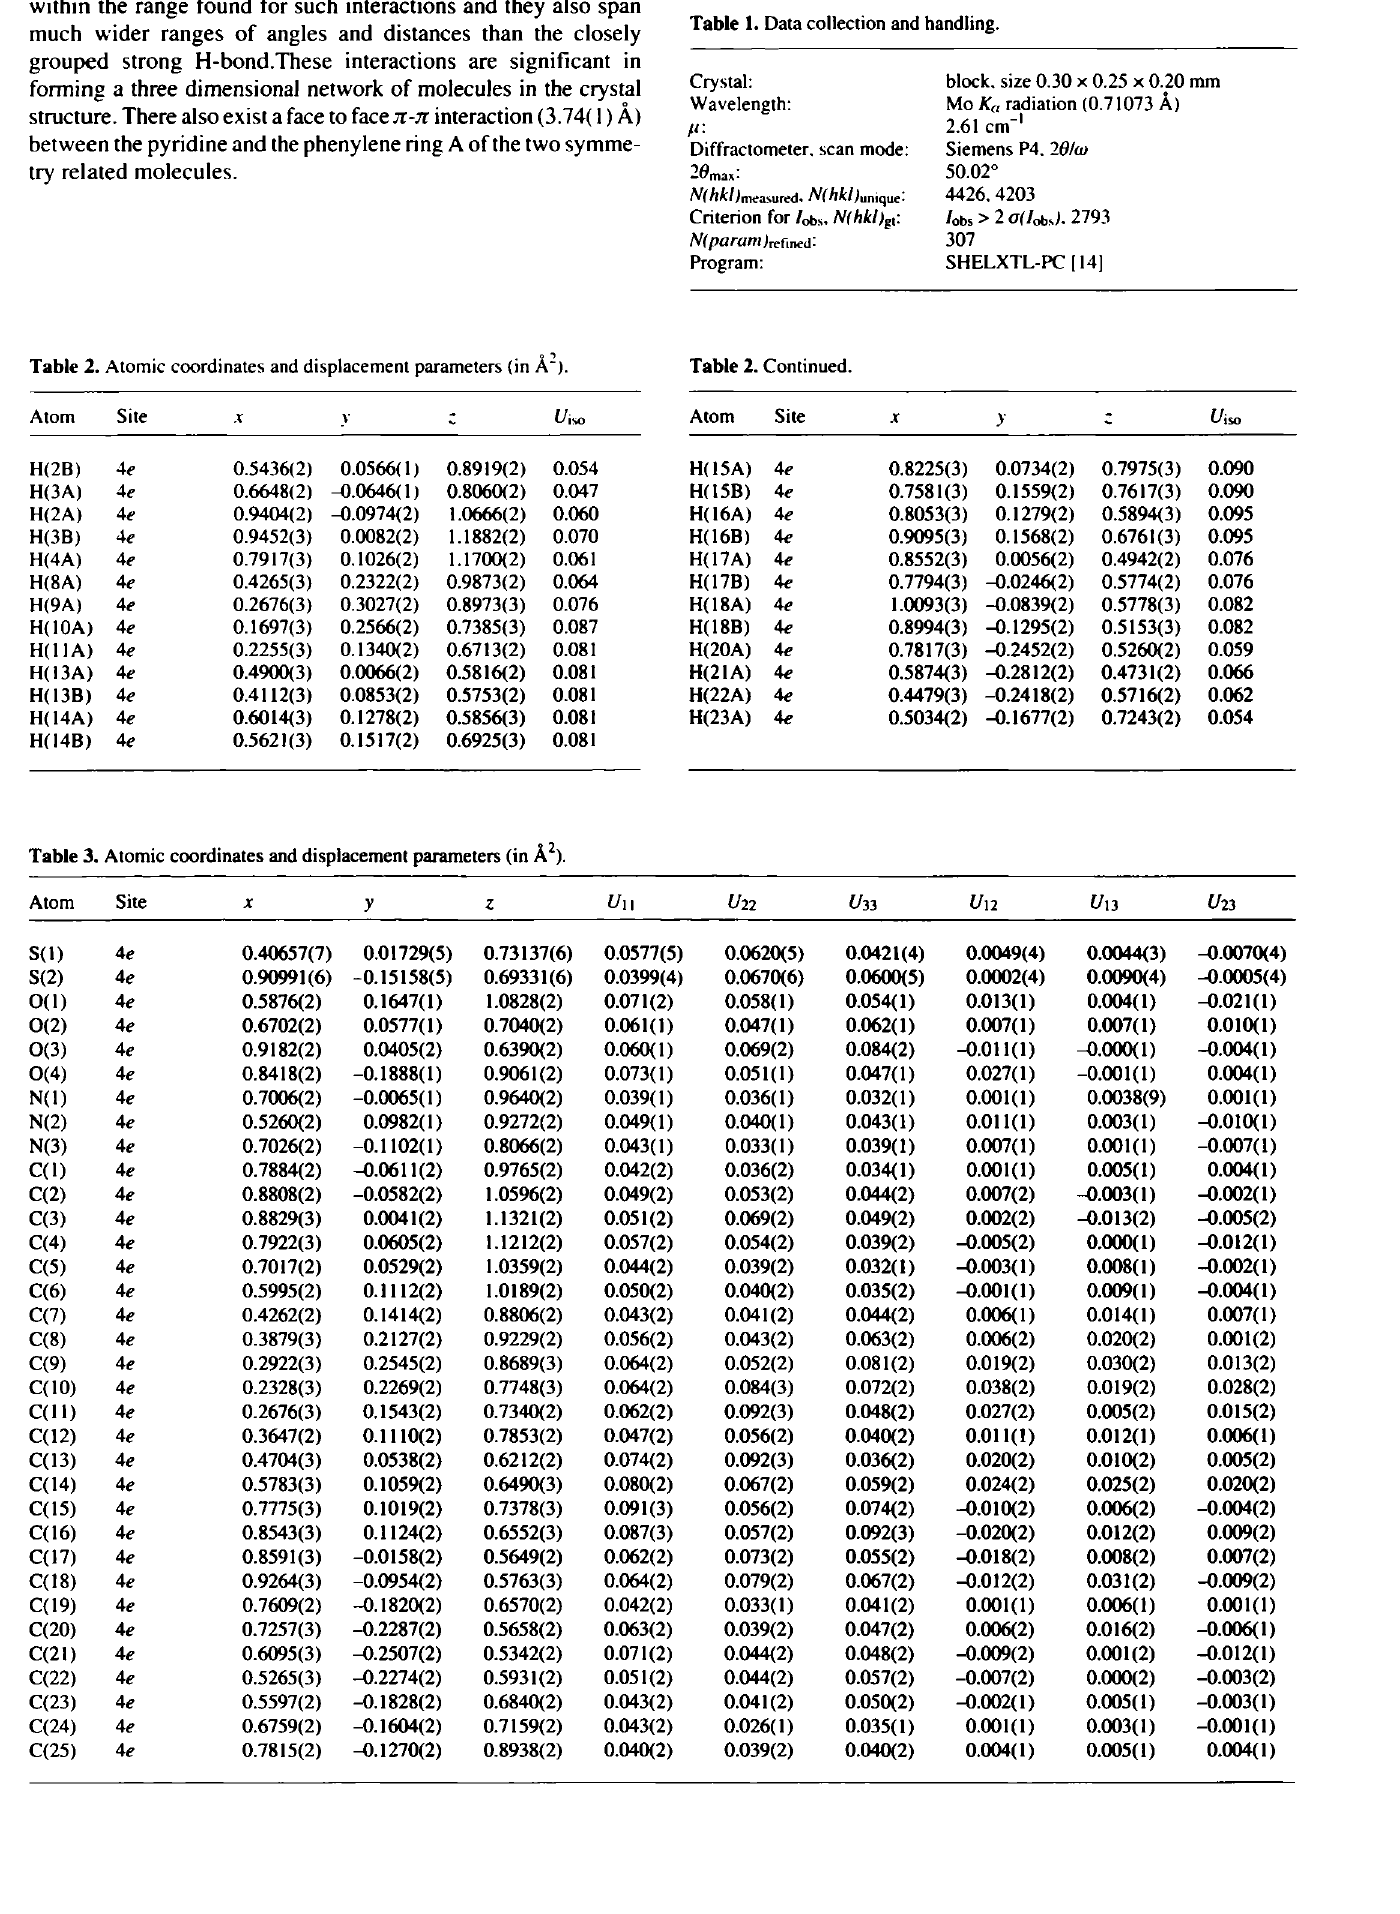
Table 2. Atomic coordinates and displacement parameters (in Â"). Table 2. Continued.